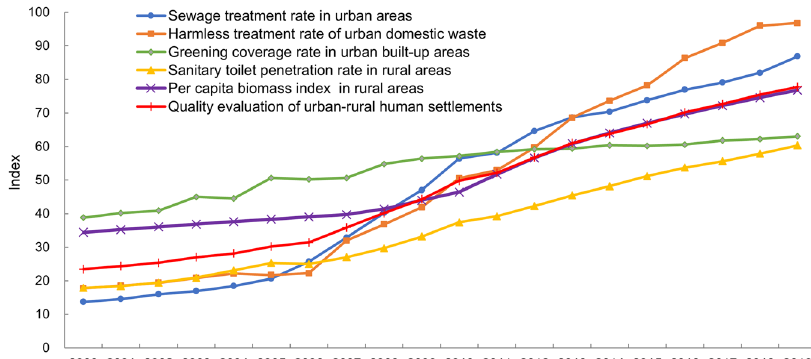
Fig. 2 Development trend of the urban – rural human settlements indexes from 2000 to 2019. Sewage treatment rate in urban areas, harmless treatment rate of urban domestic waste, greening coverage rate in urban built-up areas, sanitary toilet penetration rate in rural areas, and per capita biomass index in rural areas are shown in blue, orange, green, yellow, and purple lines, respectively. The quality evaluation of urban-rural human settlements is also shown in red